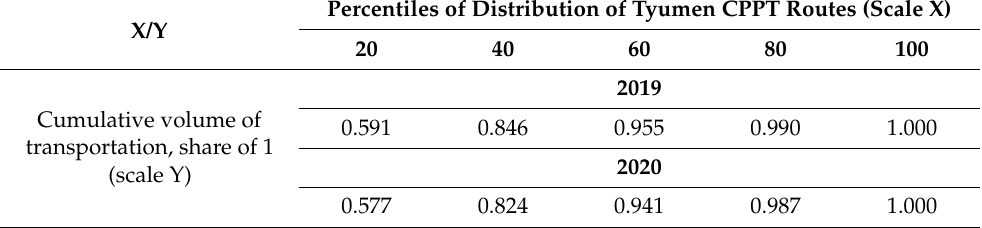
Table 10. Characteristics of the cumulative curve (Lorenz curve) of distribution of the transportation volume Q 04–06 at Tyumen CPPT routes.